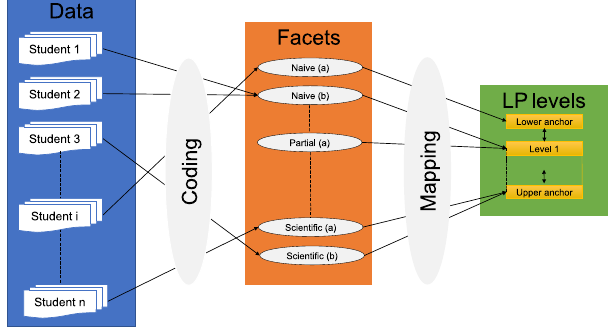
FIG. 1. Process of data analysis using the facets approach adopted in this